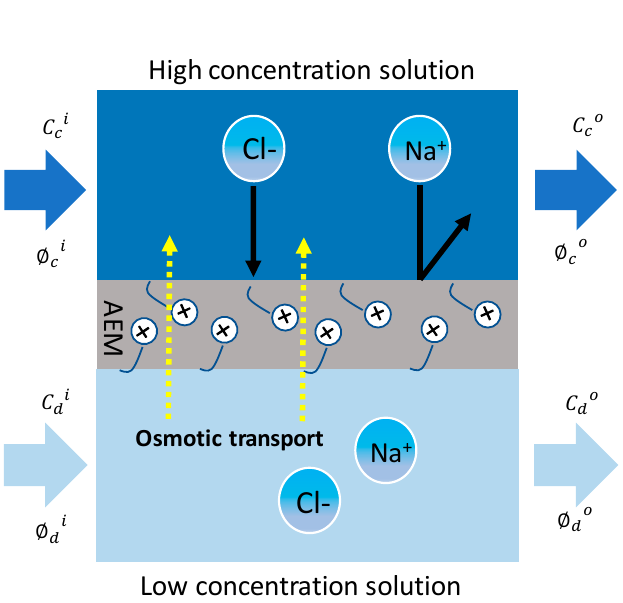
Figure 2. Transport in an AEM contacted with a NaCl feed solution.